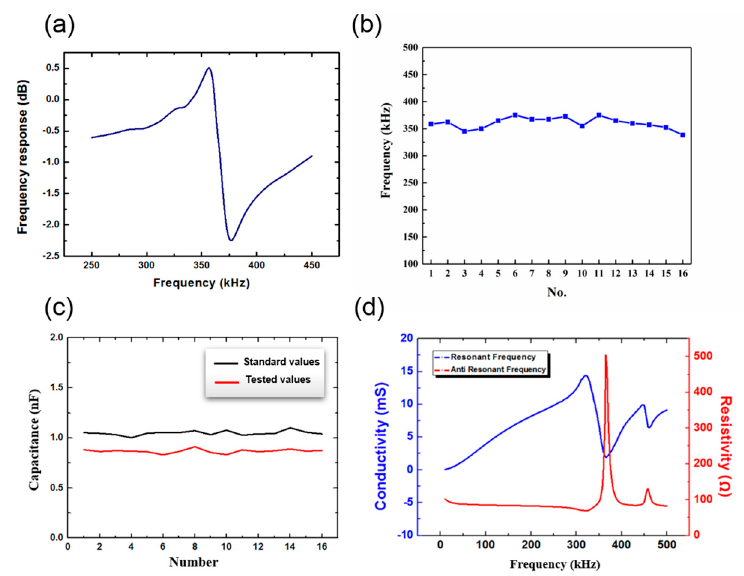
Figure 8. ( a ) The resonant frequency of the PZT. ( b ) The resonant frequency of all the PZTs in the array. ( c ) Capacitance test of the piezoelectric ceramic array. ( d ) The resonant frequency and the anti resonant frequency of the device in water.